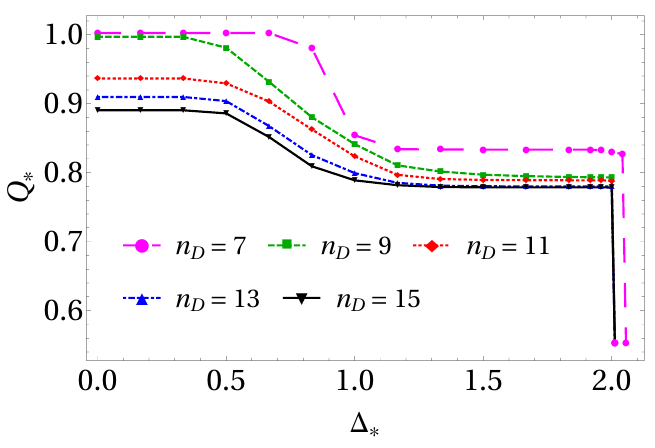
Figure 6 . Bound on the charge gap Q (cid:3) and the scalar dimension gap (cid:1) (cid:3) at c = 8. lattice shows up as a kink of bounds on lowest dimension of scalar primaries. We seek